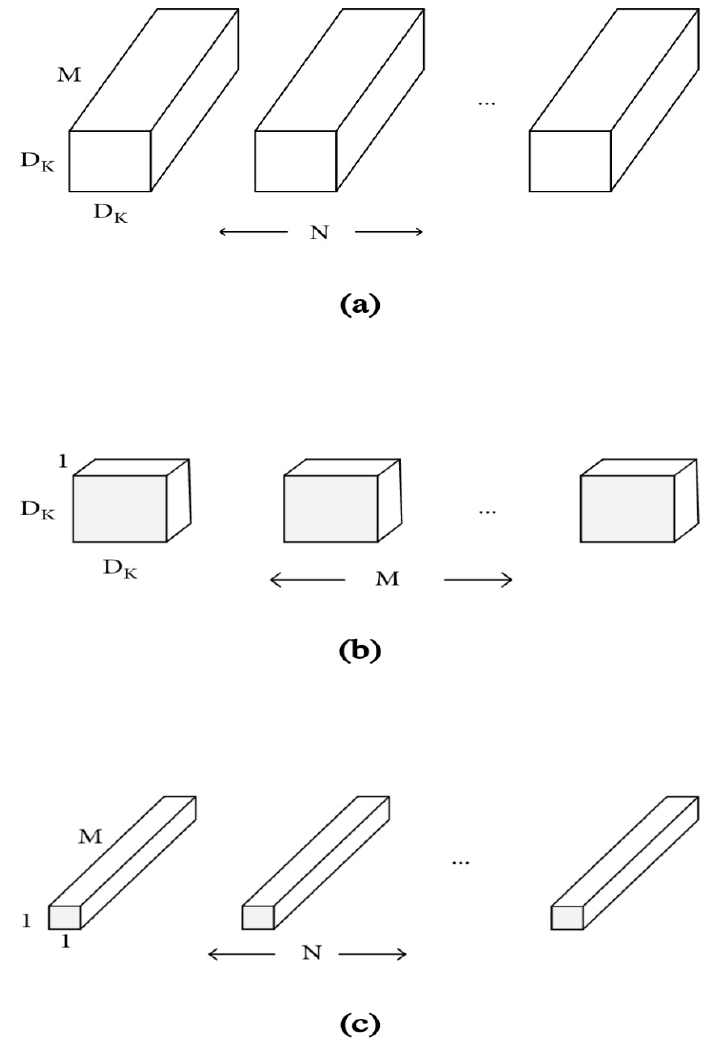
Figure 3. Standard convolutional filters and depthwise separable filters. ( a ) Standard convolutional filters. ( b ) Depthwise convolutional filters. ( c ) Point convolutional filters.